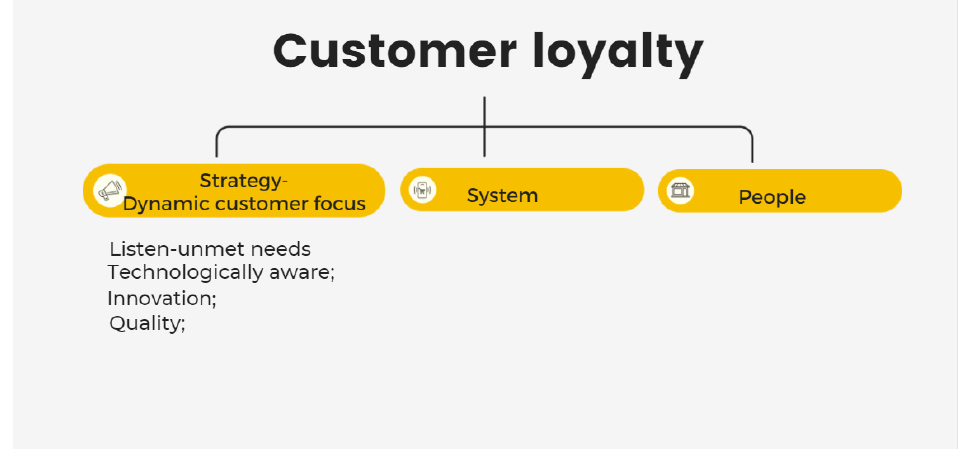
Figure 12. Market-led innovation: strategy (Doyle and Bridgewater, 2012).